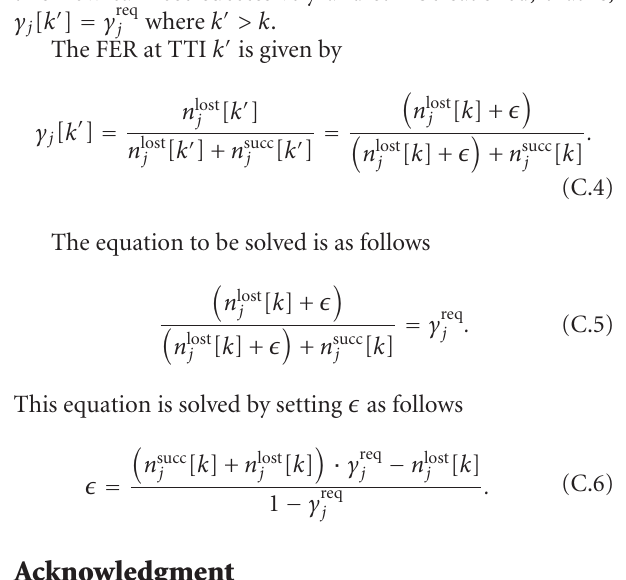
Algorithm 1: Algorithm to solve the problem